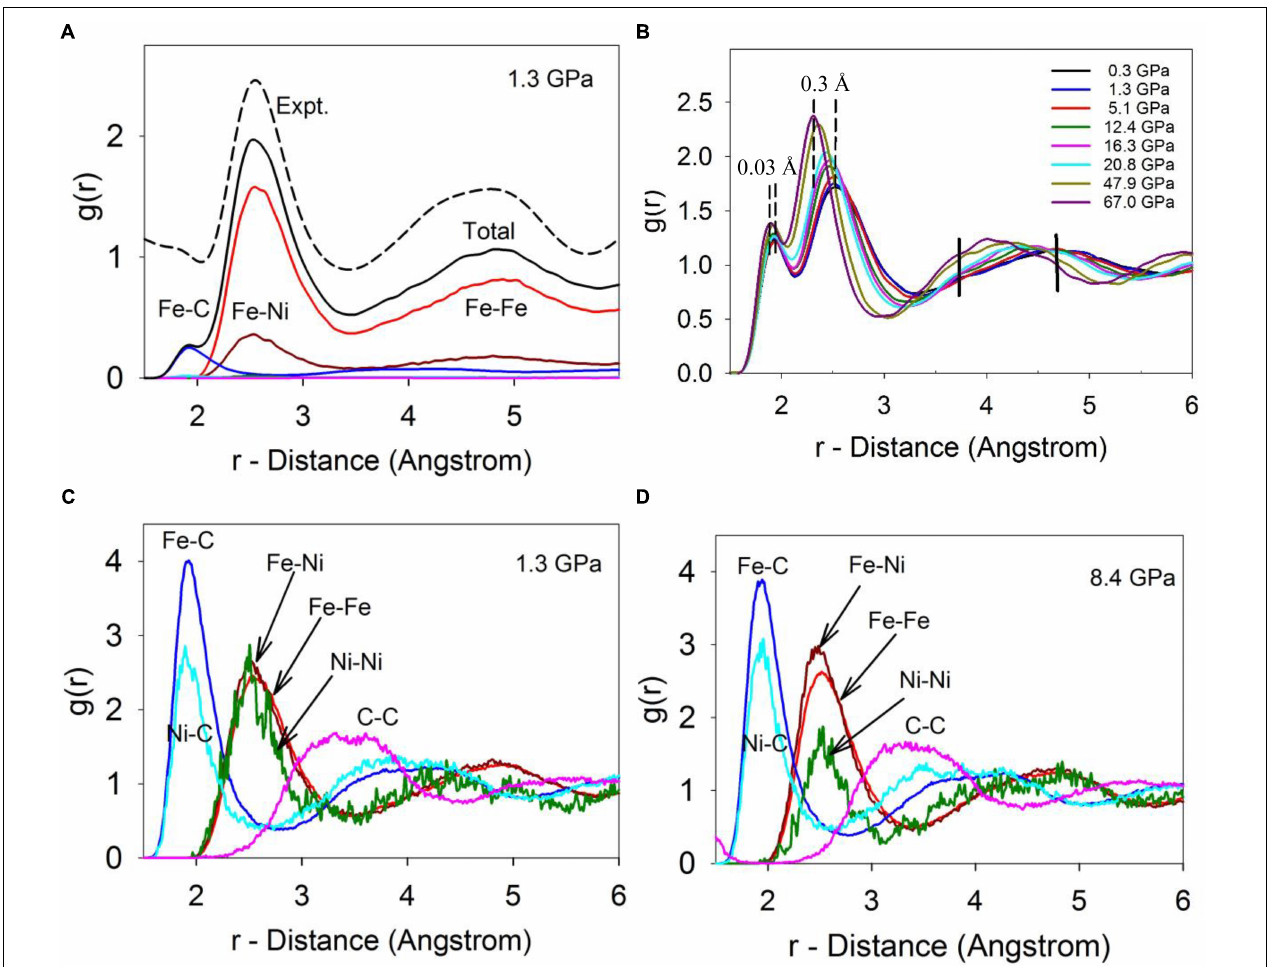
FIGURE 2 | The calculated pair distribution function (PDF). (A) Calculated total and individual PDFs at 1673 C and 1.3 GPa, in comparison with experimentally measured PDF at 1673 C and 1.5 GPa (dashed-line, top). The calculated PDFs were normalized by X-ray scattering factors in order to compare with the experimental PDF. (B) The calculated total RDFs of Fe-Ni-C liquid at 1673 K and different pressures. (C) The individual un-normalized PDFs at 1673 K and 1.3 GPa. (D) The individual pairs of PDFs at 1673 K and 8.4 GPa.